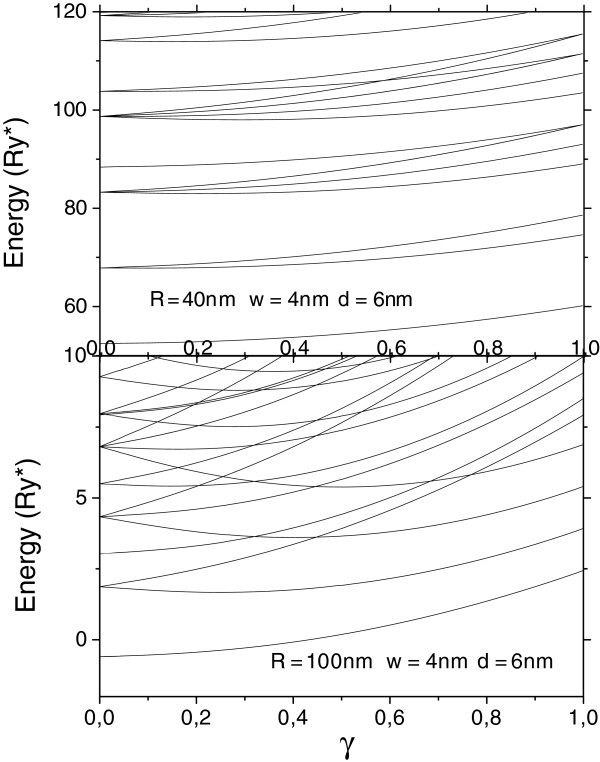
EnergiesENR,LR;nρ,lρof some low-lying levels of the double-donor complex in vertically coupled QDs. As functions of the magnetic field.